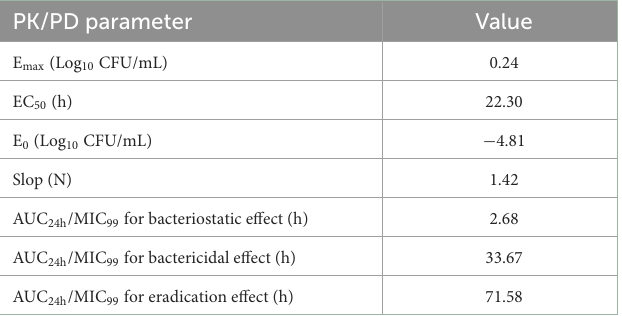
TABLE 2 Values of PK/PD parameters and AUC 24h /MIC 99 to achieve different antibacterial effects. PK/PD